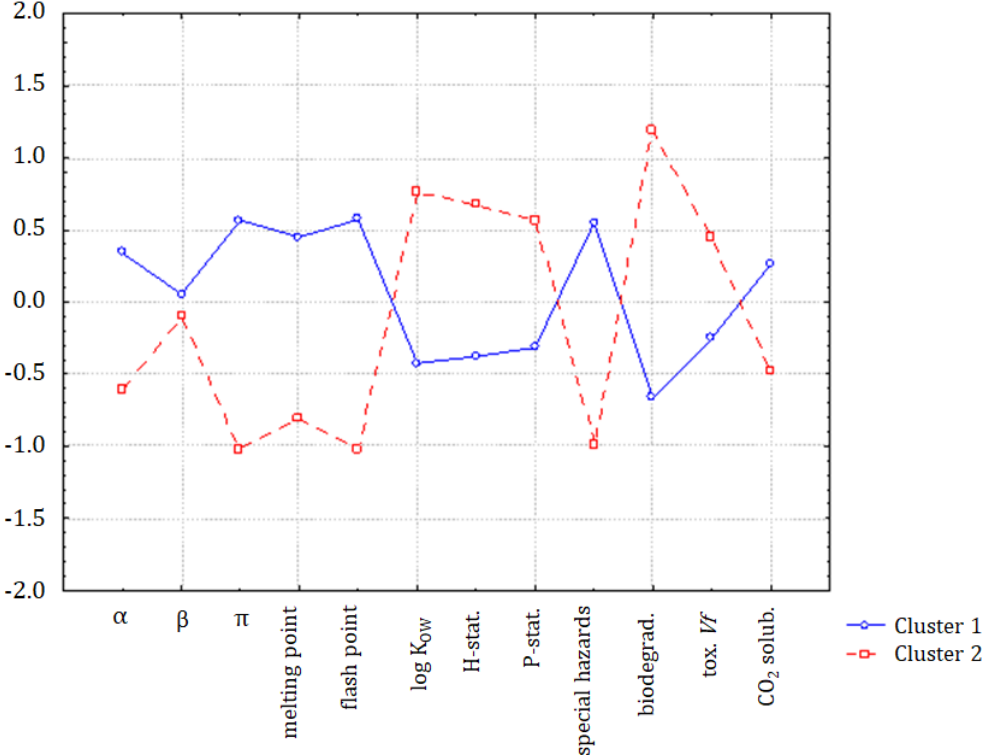
Figure 3. The average values for all variables for each of the identified clusters.